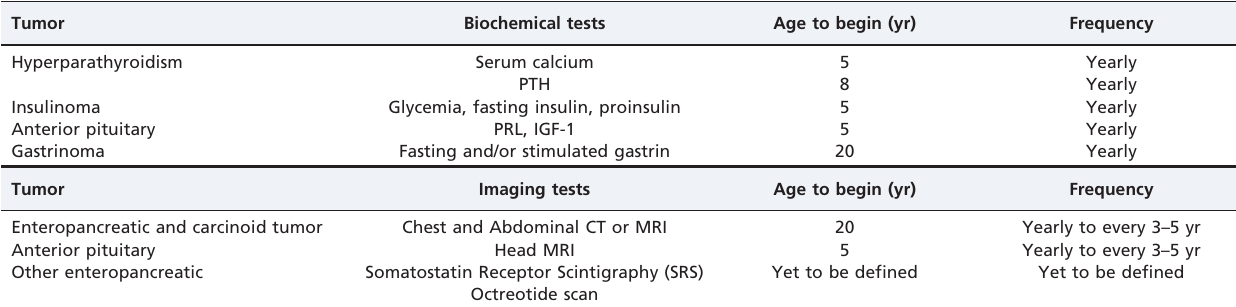
Table 2 - Clinical surveillance for subjects known to have MEN1 Adapted from